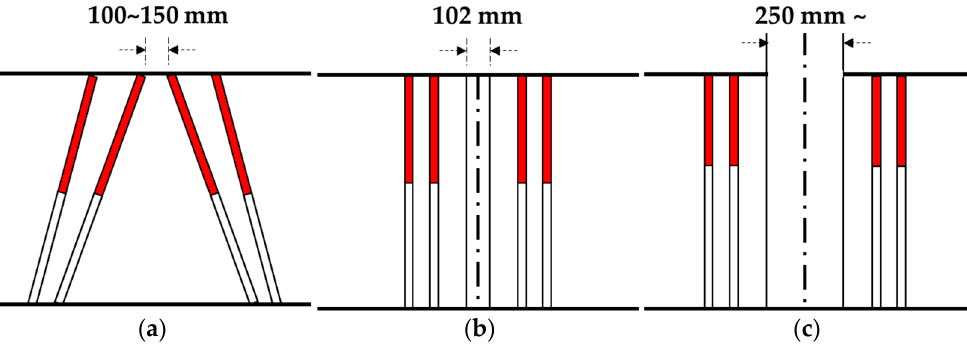
Figure 4. Schematic of the ( a ) V-cut method, ( b ) cylinder-cut method, and ( c ) LLB method.